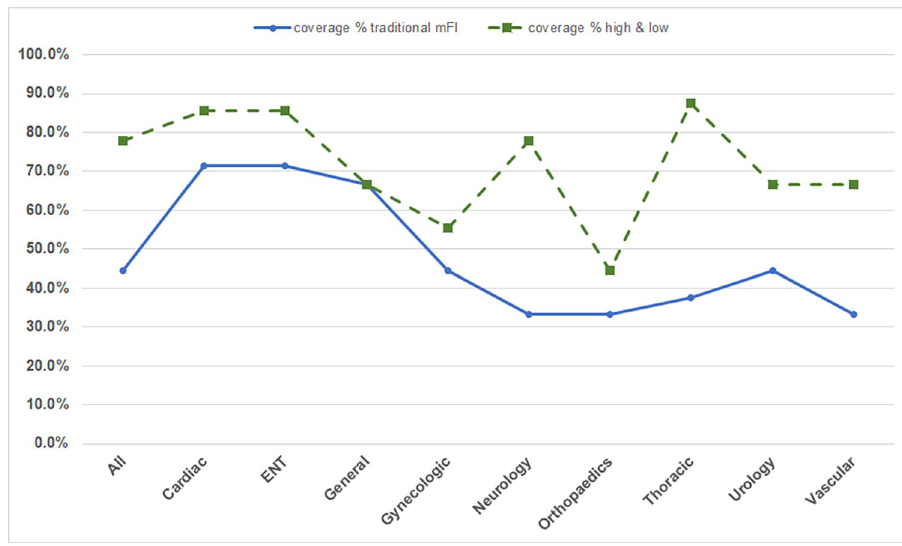
Fig 4. Percent of discharge destinations accurately predicted by the ANN mFI